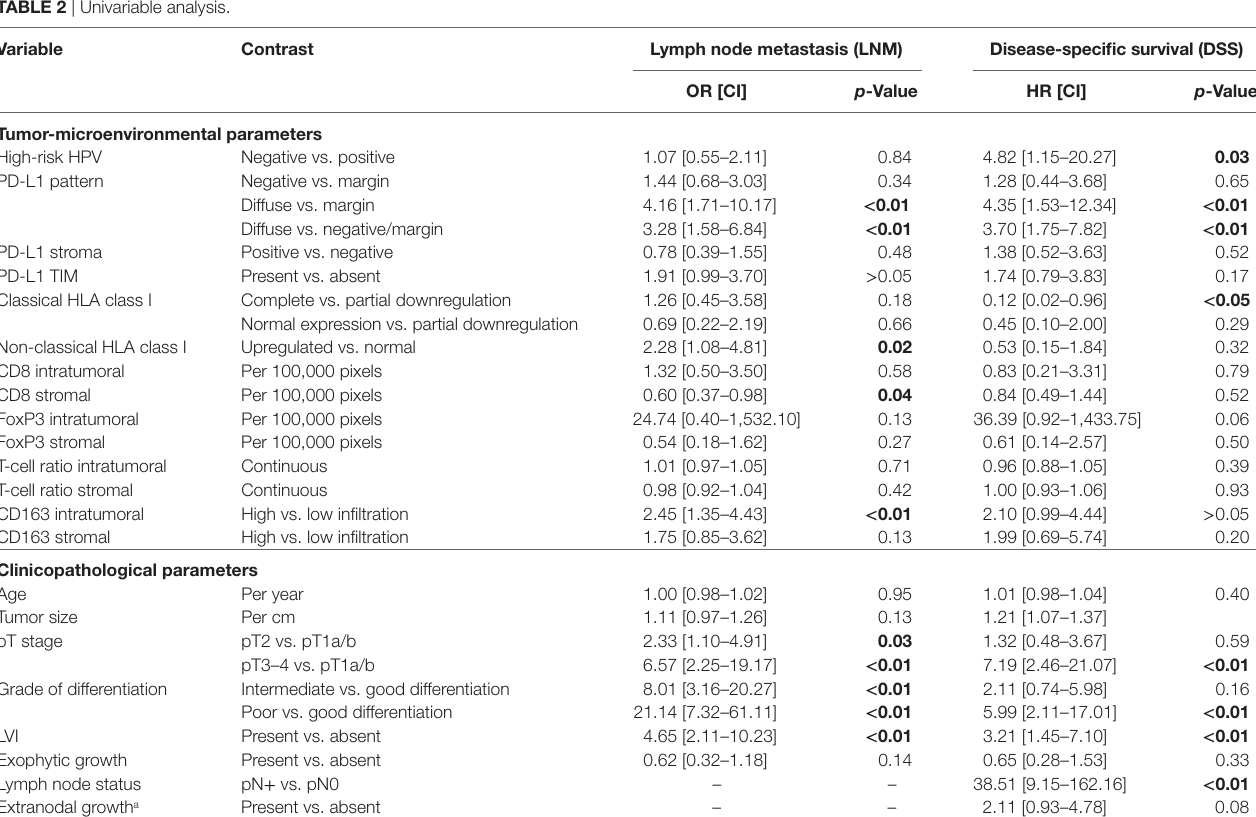
TaBle 2 | Univariable